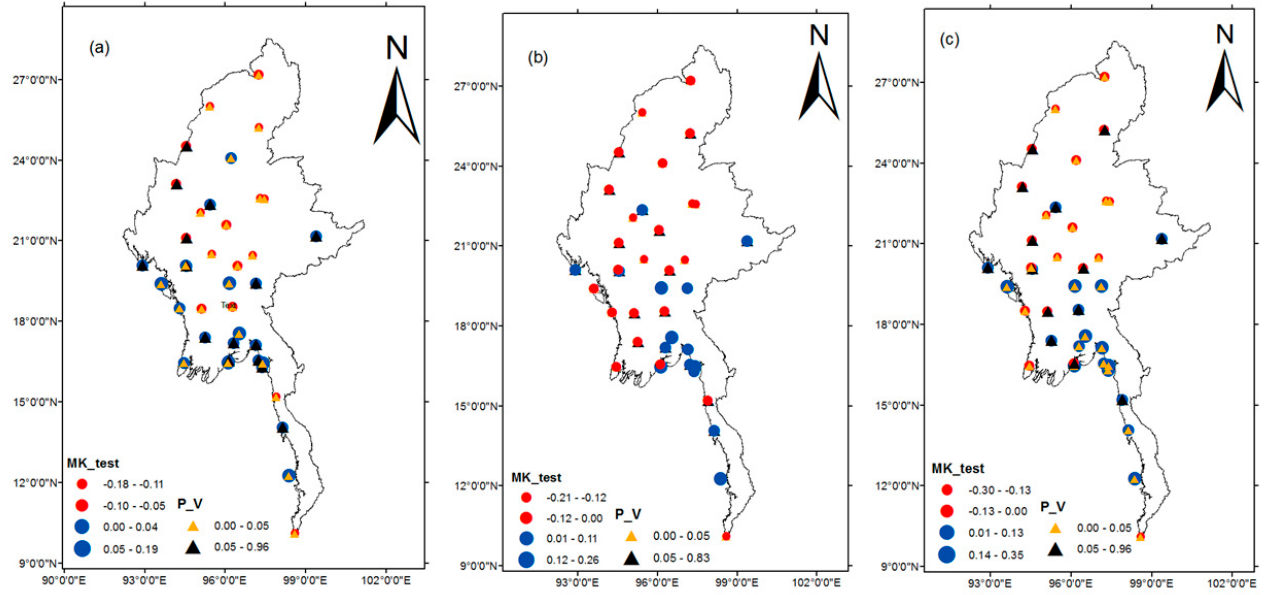
Figure 6. Spatial distribution of SPEI over Myanmar from 1986 to 2015. ( a ) 3-month; ( b ) 6-month; and ( c ) 12-month. Red and blue dots indicate negative and positive trends, respectively, while the black (significant at 5% confidence level) and yellow (significant at 10% confidence level) triangles indicate the probability value.